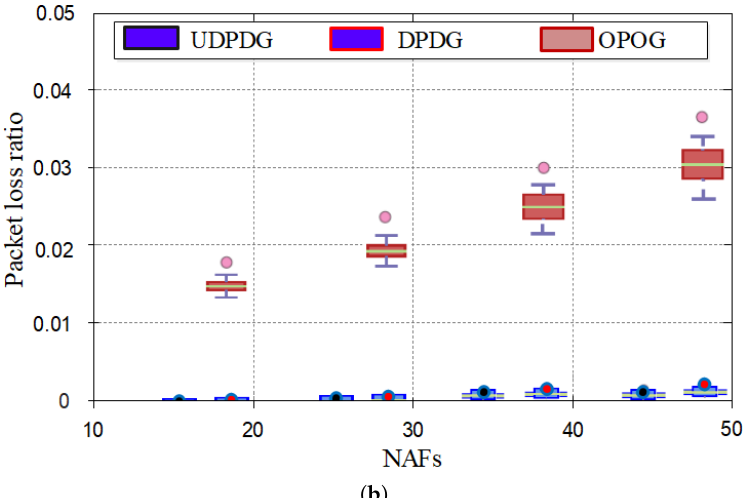
Figure 12. Results for PLR based on the NAFs. ( a ) Capture of results for displaying the PLR; ( b ) Average